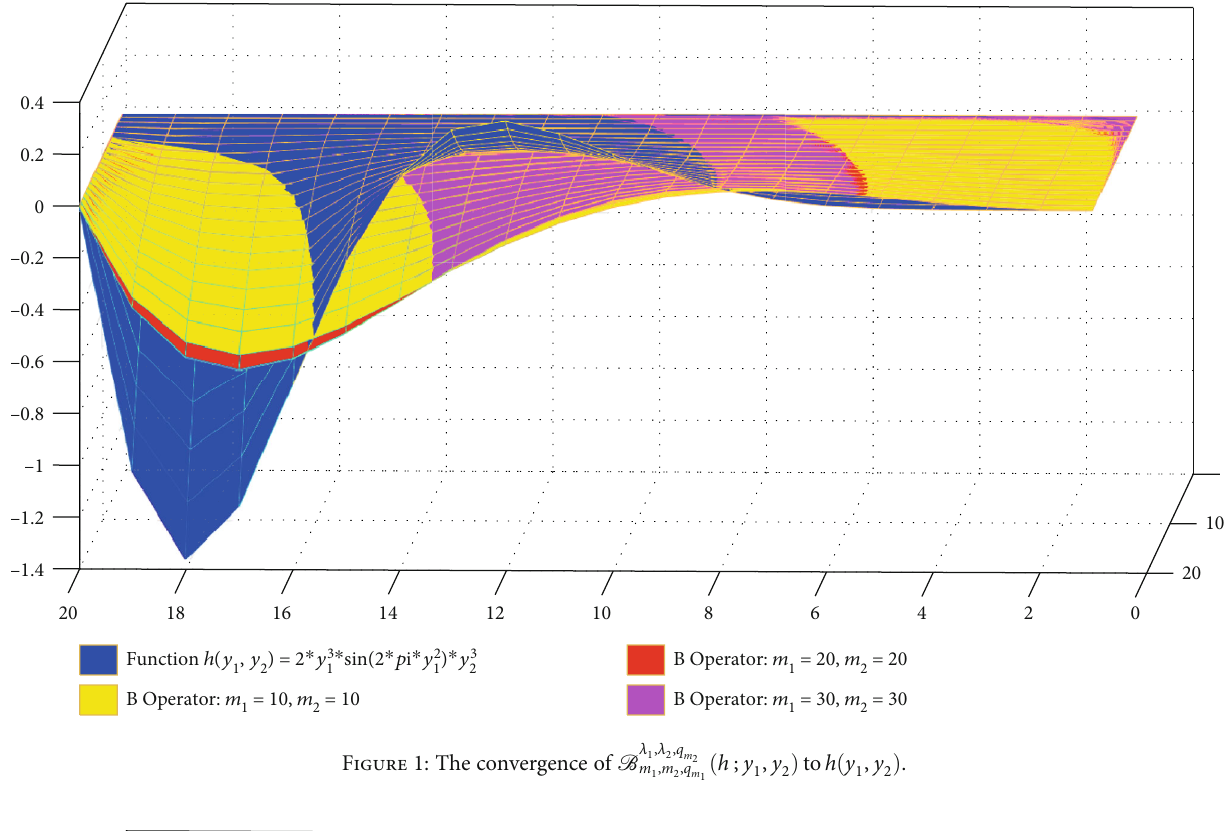
Figure 1: The convergence of B λ 1 , λ 2 , q m 2